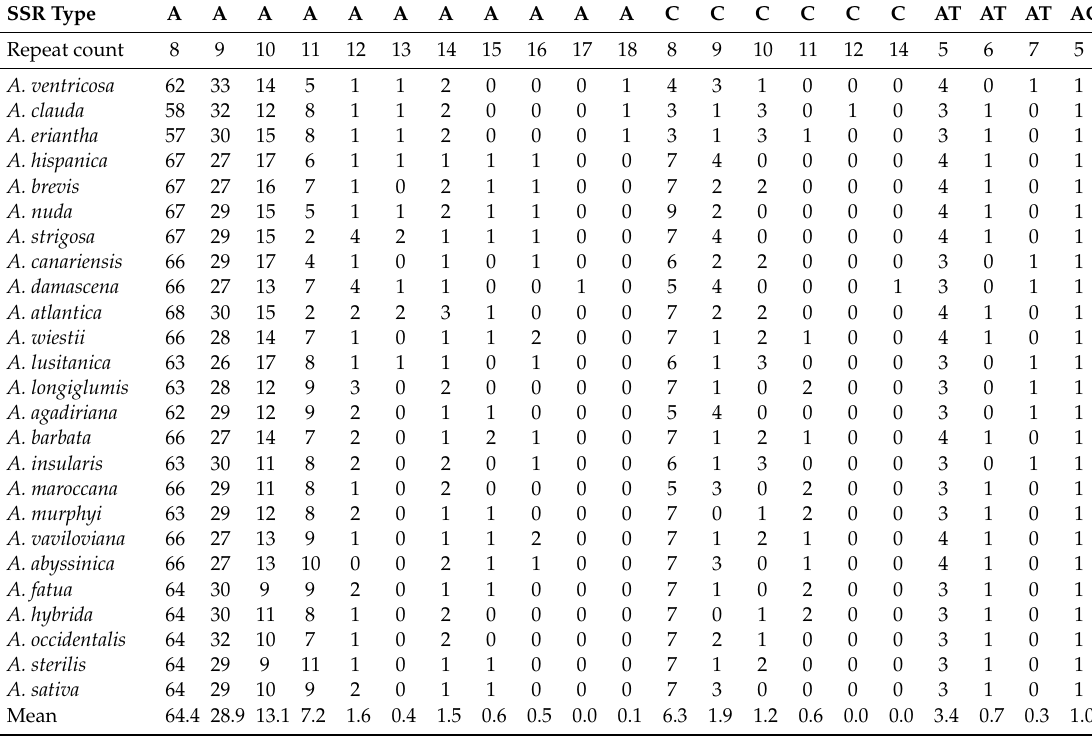
Table 3. Simple sequence repeat (SSR) polymorphism found in the plastids of 25 Avena